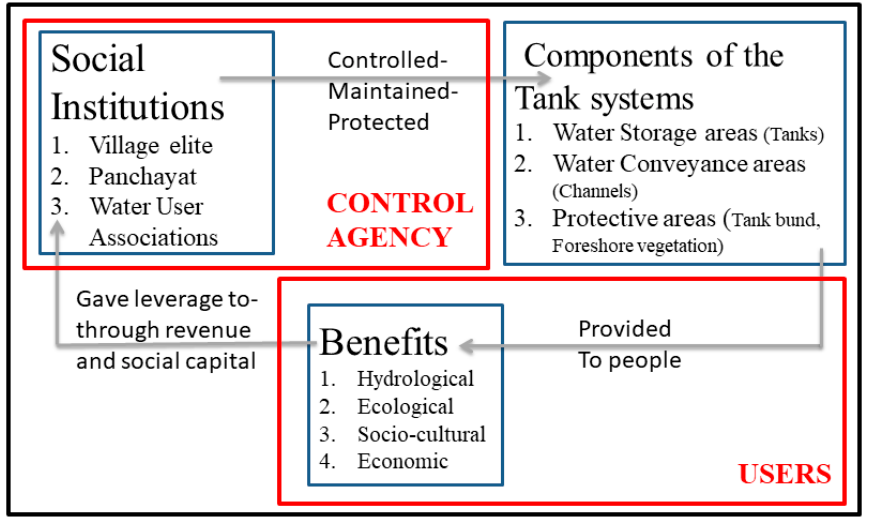
Figure 1. Traditional community managed model of tank systems (source—authors).